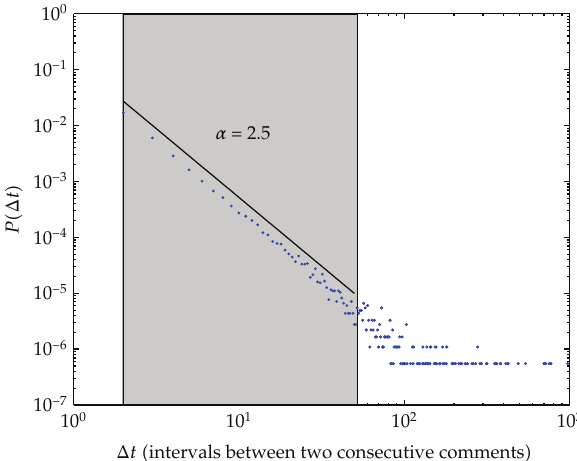
Figure 7: Distribution of intervals between two consecutive comments at the collective level, which follows power-law with exponent α (cid:8) 2 .